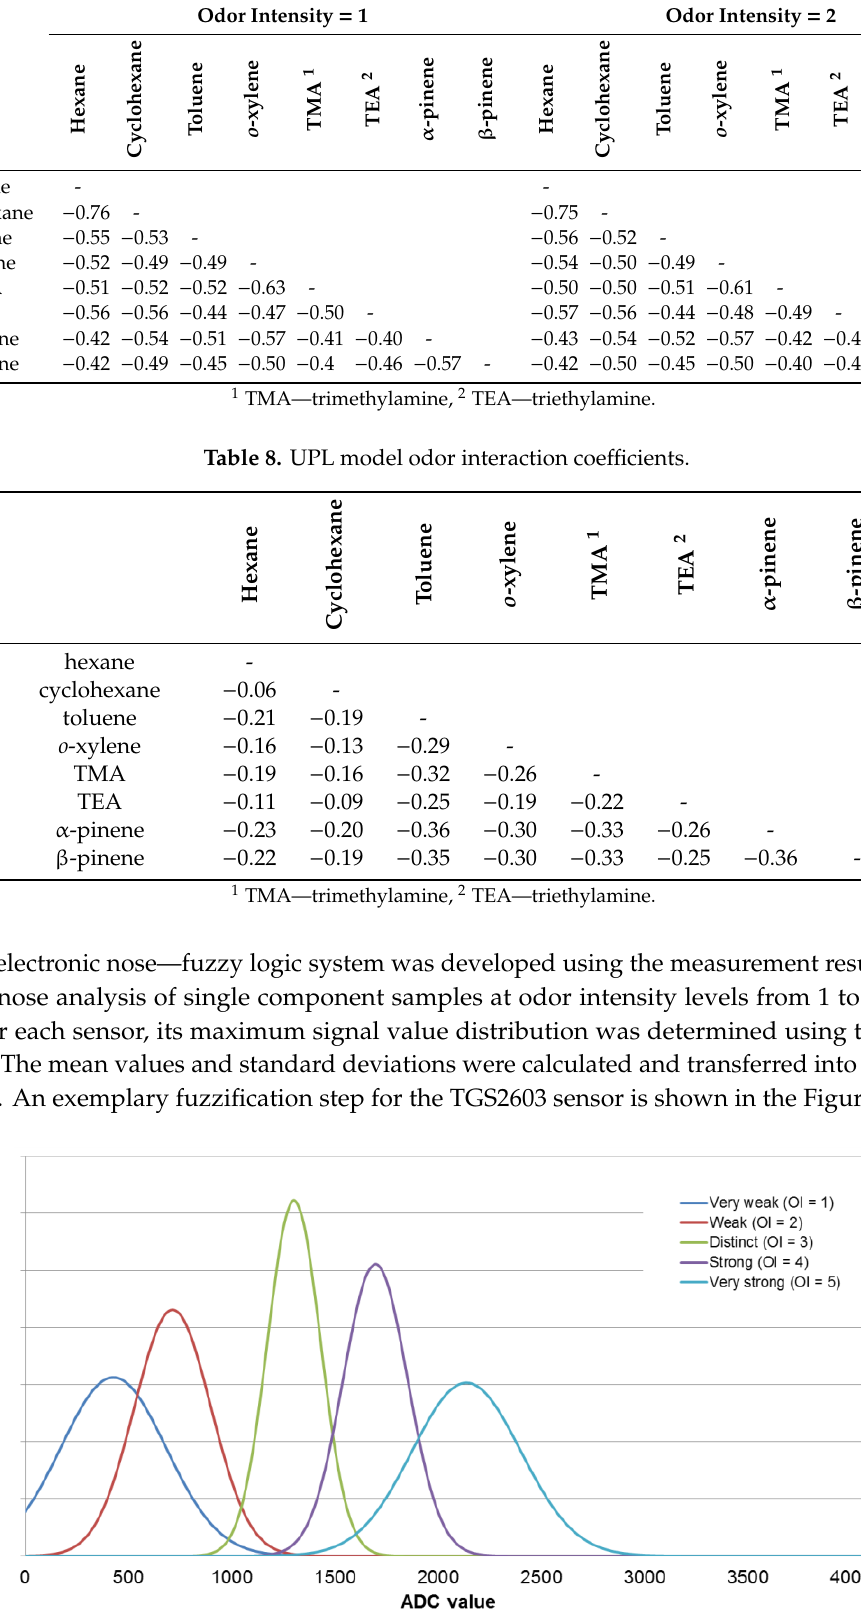
Figure 5. Gaussian membership functions calculated for the TGS2603 sensor.